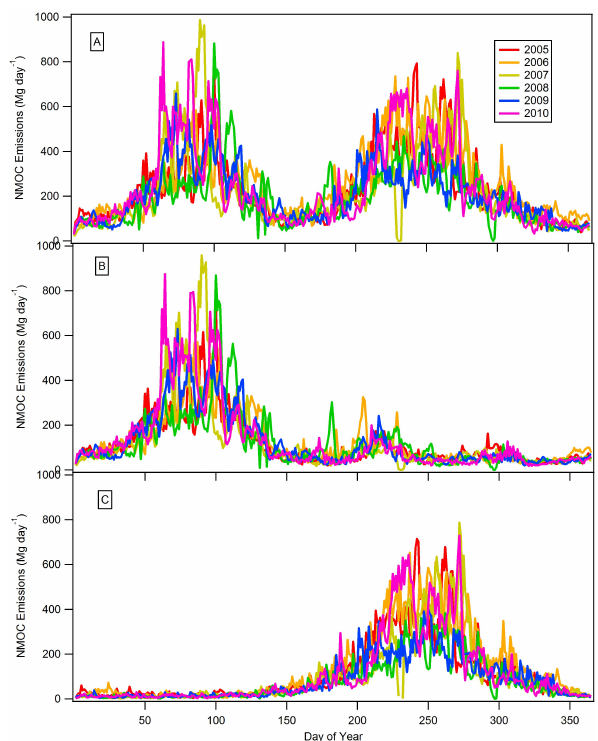
Fig. 5. Daily emissions of NMOC from fires for 2005 through 2010 for (A) the globe, (B) the Northern Hemisphere, and (C) the South- ern